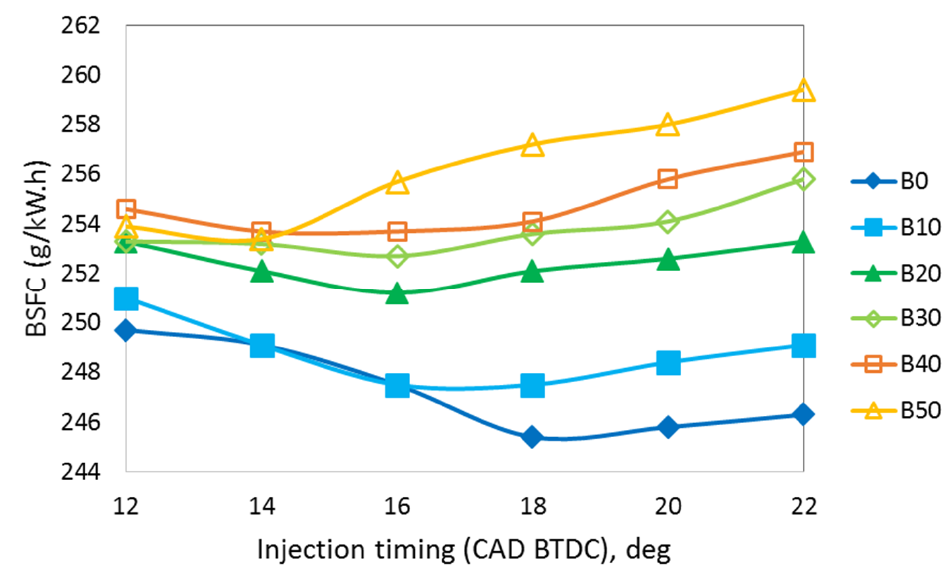
Figure 15. Effect of injection timing on engine BSFC.